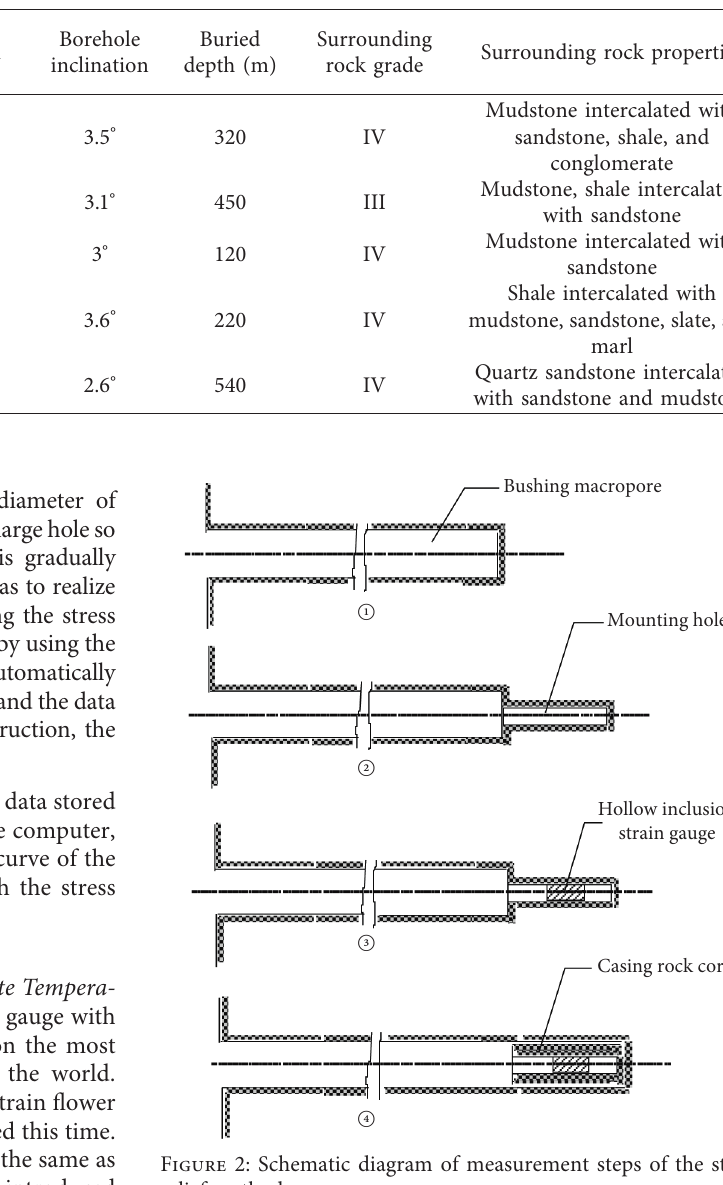
Table 1: Surface location of each measuring point and parameters of the test hole for in situ stress.